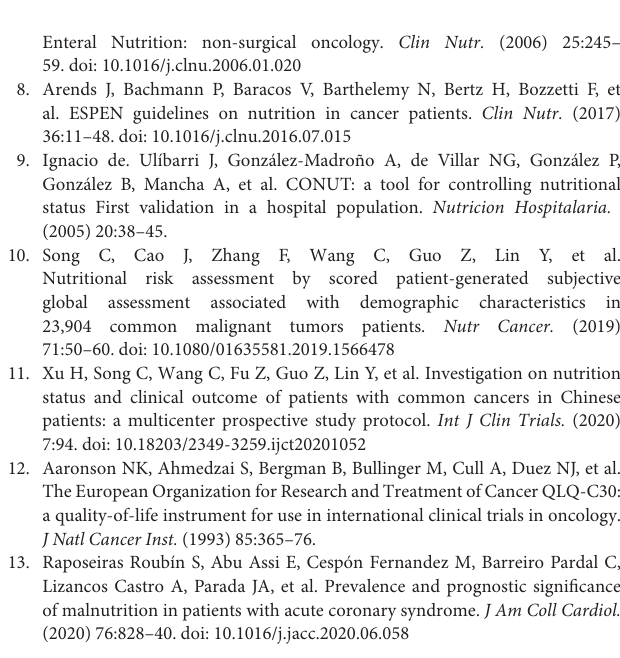
Supplementary Table 7 | Univariable Cox regression analyses of factors predicting all-cause mortality. Supplementary Table 8 | Multivariate Cox proportional hazards analyses of malnutrition indexes to predict all-cause mortality according to the location of cancer. Supplementary Table 9 | Multivariate Cox proportional hazards analyses of malnutrition indexes to predict all-cause mortality according to exclude patients died within 6 months. Supplementary Table 10 | Each parameter of EORTCQLQ–C30 stratified by CONUT.